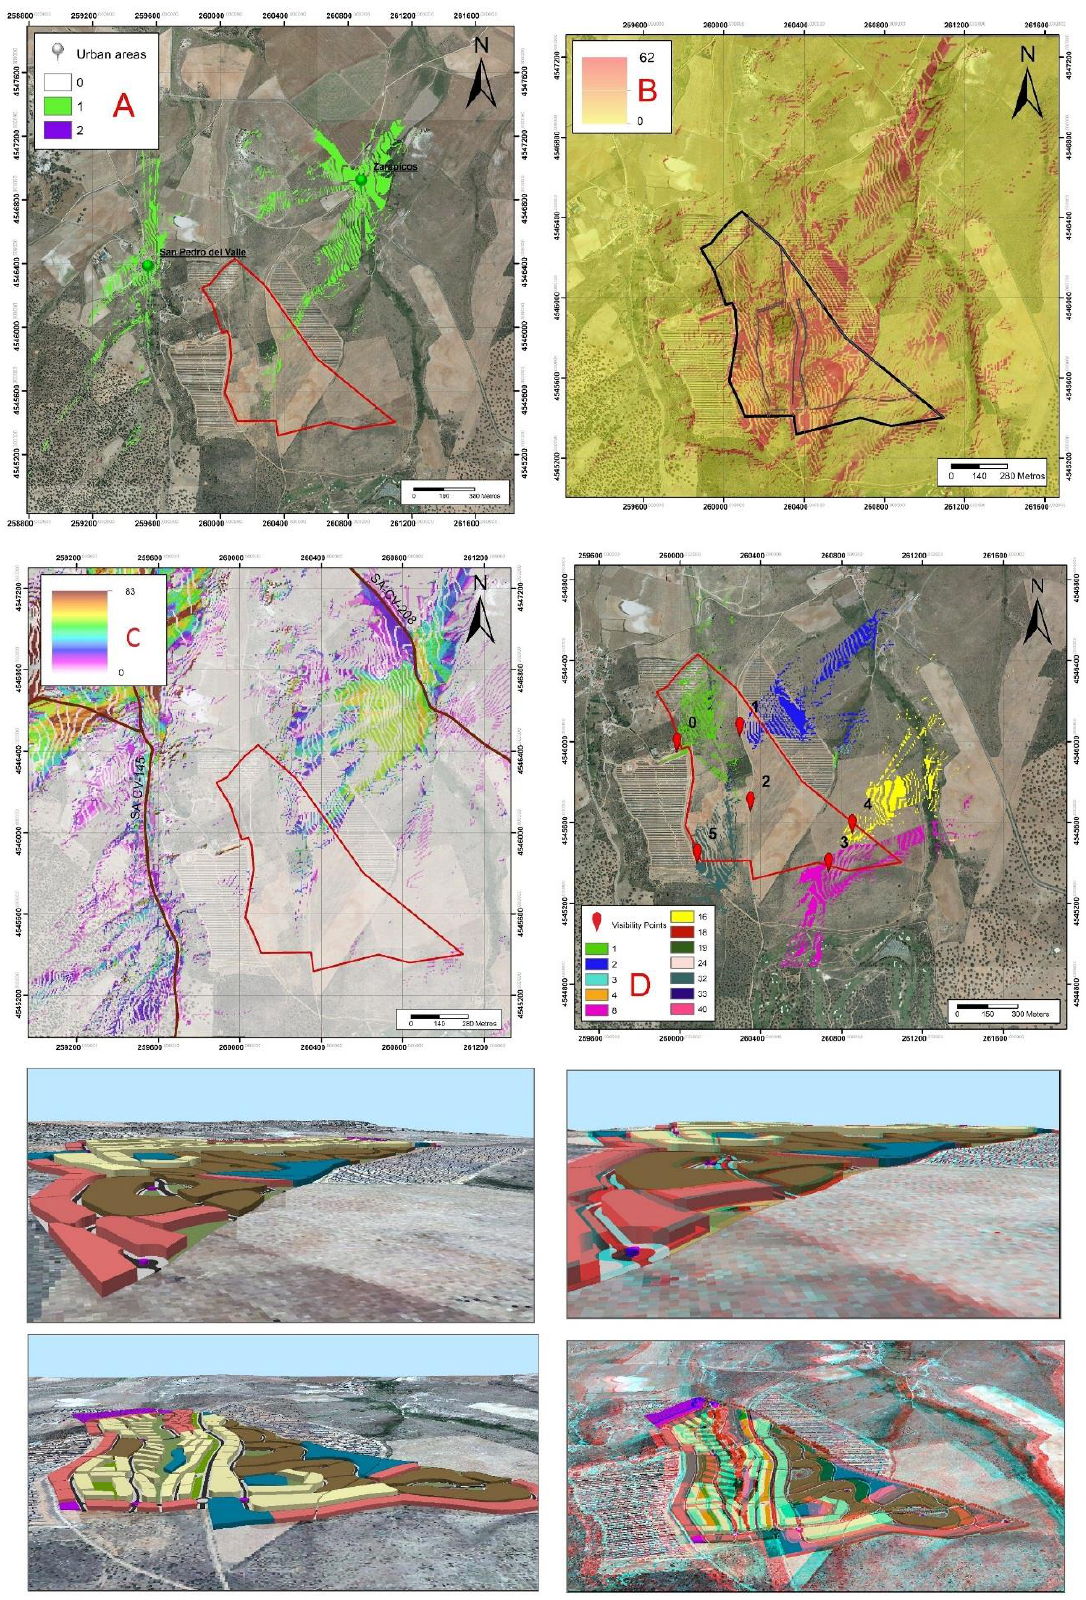
Figure 5. Visibility analysis by indirect methods: visual basins of ( A ) the nearest villages; ( B ) visual basins of roads; visual basins of ( C ) the principal watercourse; and direct methods: visual basins of ( D ) points of observation. Down : extrusion ( left ) and anaglyphs ( right ).